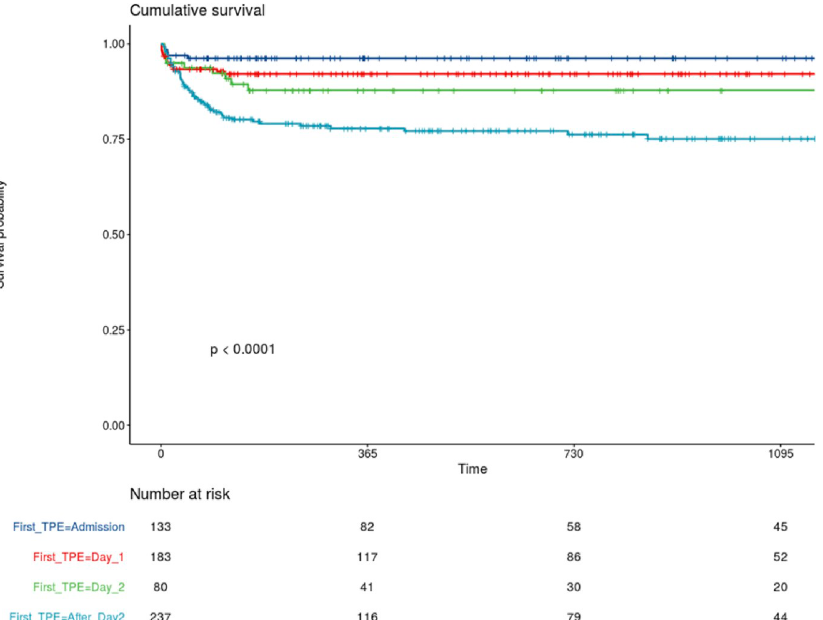
Fig 2. Survival analysis. Kaplan-Meier curves of survival probability for patients with TTP grouped by timing of first TPE (day of admission, day 1, day 2, after day 2). Logrank test showed a significant effect of TPE timing on long-term survival ( P <